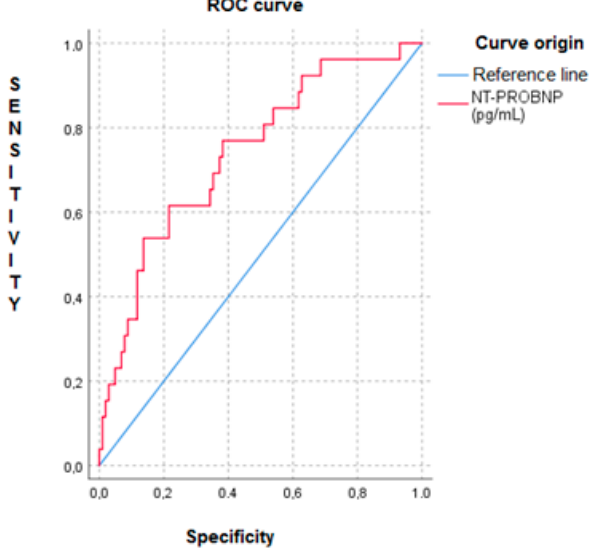
Figure 2. ROC curve of the NT-proBNP levels for in-hospital mortality and 30-day follow-up in patients with AHF.